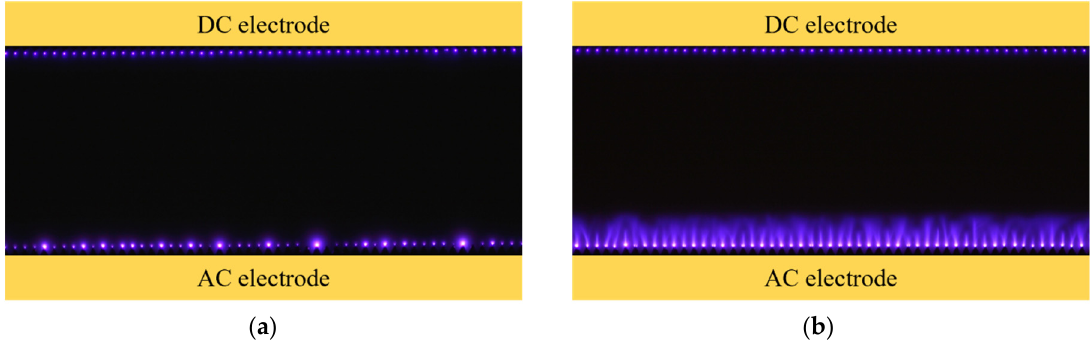
Figure 12. Discharge photographs in the case where a voltage of 10 kV pp at 4 kHz was applied to the AC electrode, and a voltage of 14 kV was applied to the DC electrode, in the ( a ) CD-PA and ( b ) TED-PA.